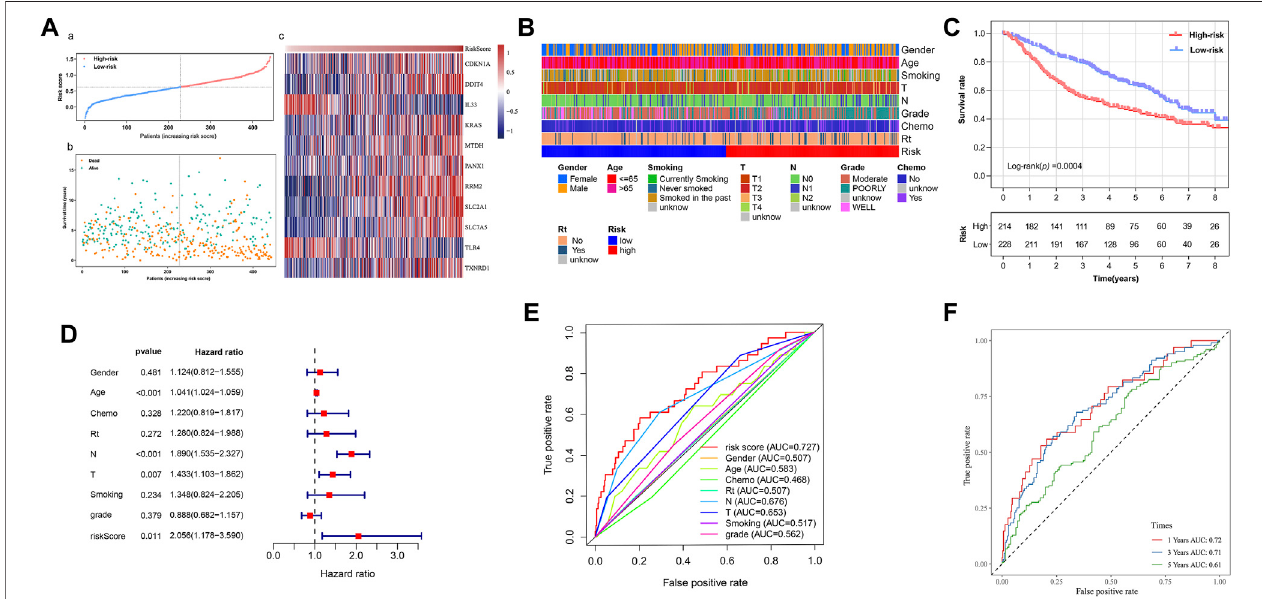
FIGURE4| ThevalidationofprognosticsignatureintheGEOtumorcohort. (A) Thedistributionofsurvivalstatus,survivaltime,andriskscoreandtheexpressionof model genes in two risk groups. (B) Heatmap of clinicopathological feature distribution in two risk groups. (C) Kaplan – Meier survival curve of high- and low-risk groups. (D) Multivariate Cox regression analyses on overall survival. (E) ROC curves for predicting overall survival of clinical factors and risk score. (F) ROC curves for predicting the 1-, 3-, and 5-year survival of risk score. ROC: receiver operating characteristic curve. AUC: area under the curve. Chemo: chemotherapy. Rt: radiotherapy.